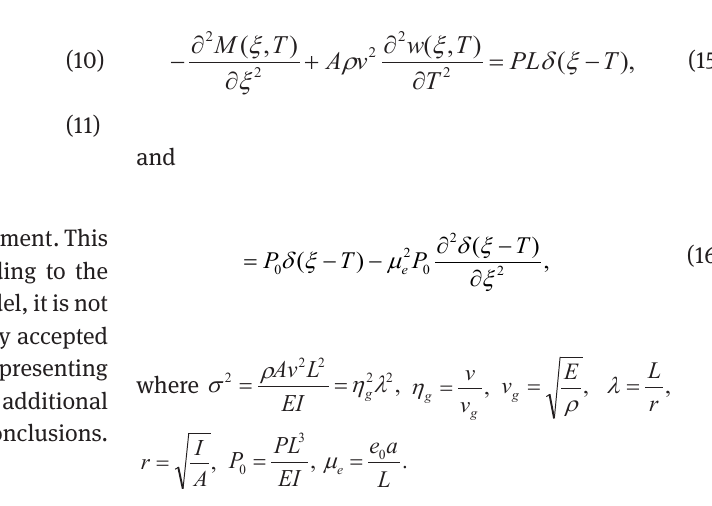
Figure 1: Beam under moving